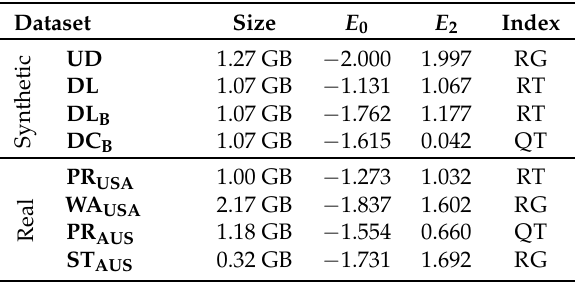
Table 4. g used in the experiments: UD = uniform distribution, DL = diagonal line, DL B = diagonal line with buffer, DC B = double cluster with buffer, PR USA = USA primary roads, PR AUS = Australian primary roads, WA USA = USA water areas and ST AUS = Australian states. In the 6th column: RT = Rtree, QT = Quadtree, and RG = regular